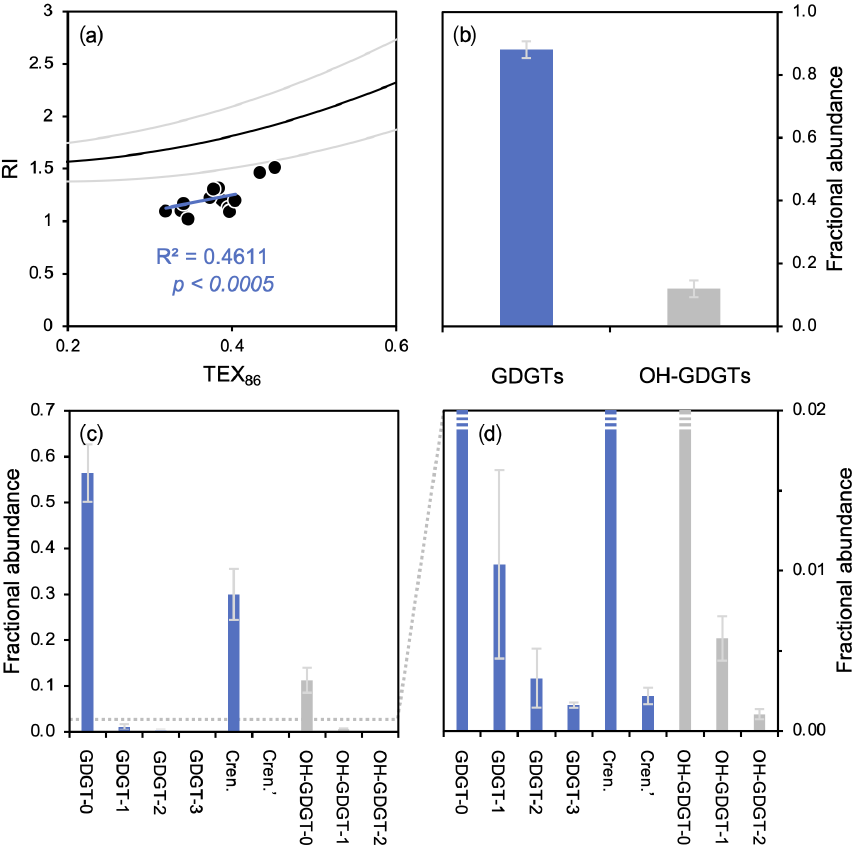
Figure 6. GDGT- and OH-GDGT distributions and average fractional abundances and standard deviations for this study’s dataset ( n = 13). (a) TEX 86 versus RI showing the global polynomial equation and 95% uncertainty envelope (black and gray lines, Zhang et al., 2016) and Baffin Bay sediments (black dots), (b) fractional abundance of total GDGTs (blue) and OH-GDGTs (gray), and (c–d) fractional abundance of individual GDGTs (blue) and OH-GDGTs (gray) at two different